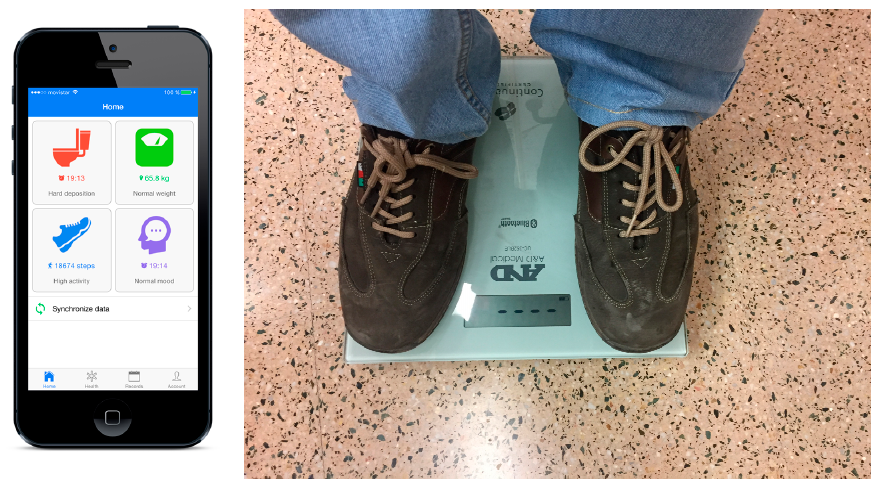
Figure 6. Technological architecture of system components.